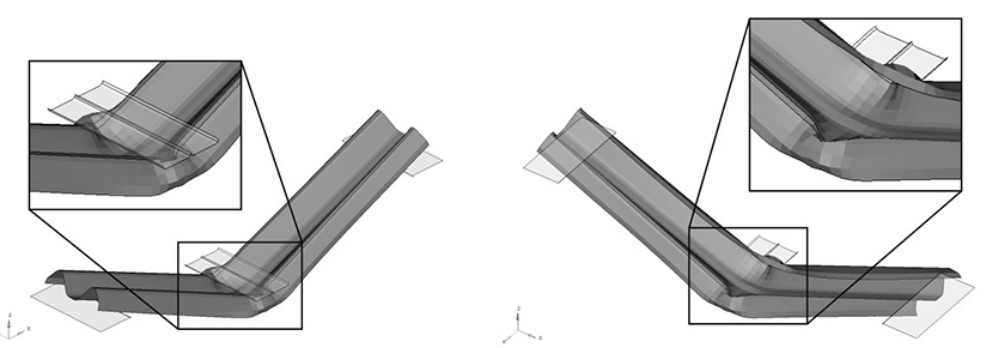
Figure 9. Final deformation of guide rail